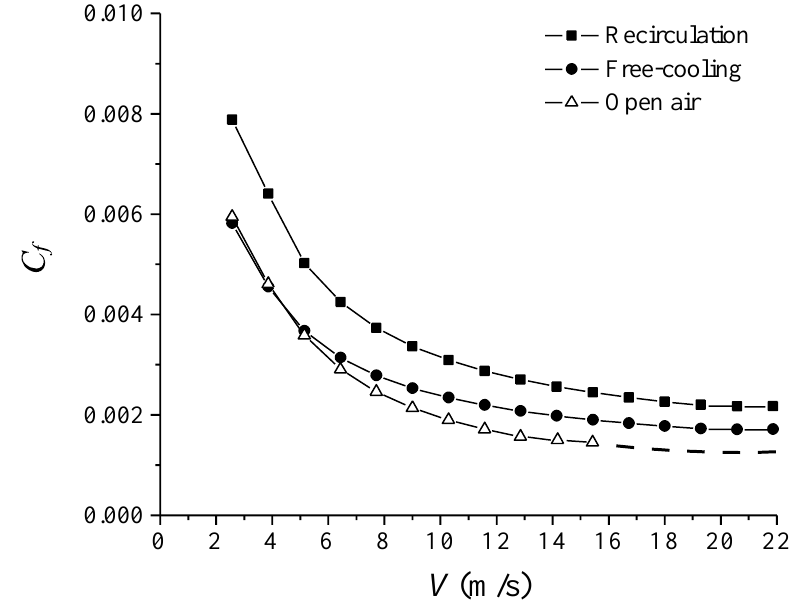
Figure 11. Friction drag coefficient C f in the two ventilation modes and in the open